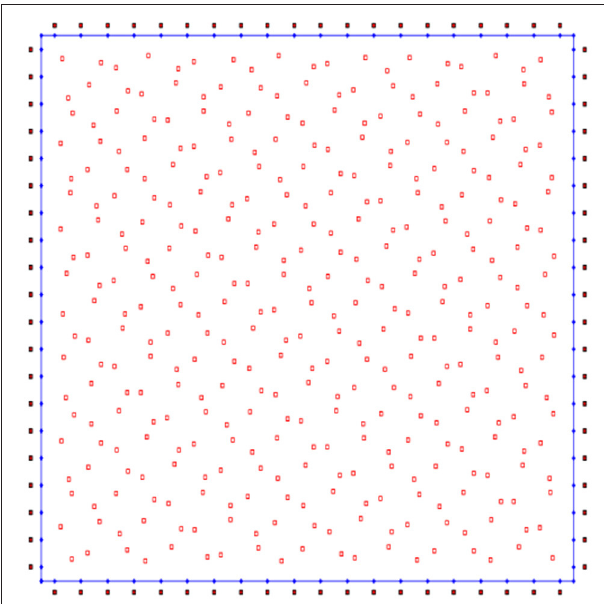
FIGURE 7 | Shell irregular collocation scheme: MAEM.